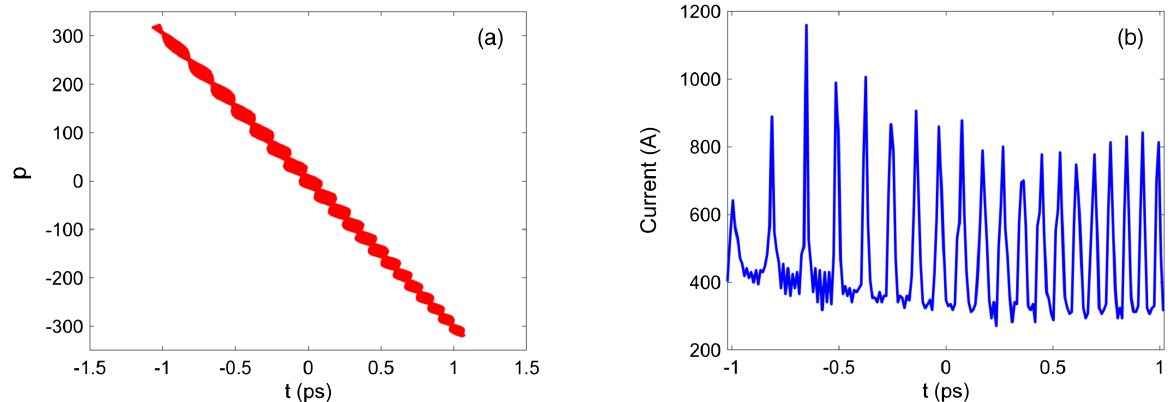
FIG. 5. Simulation results of the modulation at the exit of the second dispersion section. (a) Longitudinal phase space; (b) density distribution. The head of the beam is on the right